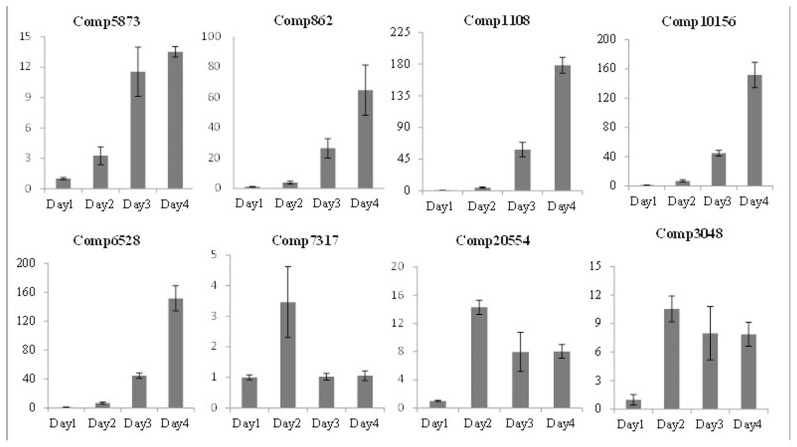
qRT-PCR analysis of 8 selected Citrullus colocynthis genes under drought treatment.The y-axis indicates relative expression compared with Day 1 expression of each gene. The x-axis shows days of water-withholding time points.